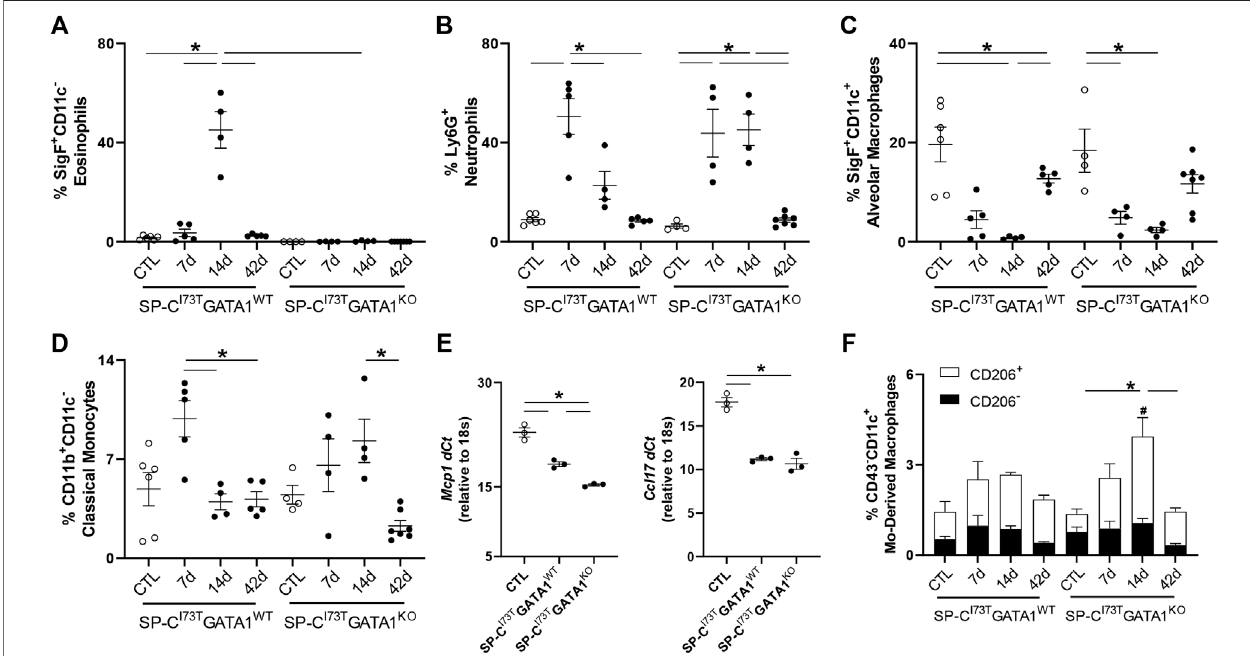
FIGURE 4 | Effects of genetic eosinophil lineage ablation on myeloid in fl ammatory cell dynamics following SP-C I73T induced injury. (A – D,F) Flow cytometric quanti fi cation of (A) Ly6G + neutrophils, (B) SigF + CD11c − CD11b + eosinophils, (C) SigF + CD11c + CD11b − alveolar macrophages, (D) CD11b + CD11c − classical monocytes, and (F) CD43 − CD11c + monocyte-derived macrophages prepared from collagenase digested lungs from oil treated controls (Ctl), or tamoxifen treated SP- C I73T GATA1 WT and SP-C I73T GATA1 KO mice at 7 days,14 days,or42 days postinjury. A p < 0.05 (*)wasconsidered signi fi cant.Lines marksigni fi cantgroups. (E) mRNA analysis of BAL cells isolated from oil treated controls (Ctl), or tamoxifen treated SP-C I73T GATA1 WT and SP-C I73T GATA1 KO mice 14 days post injury. Data is expressed as Delta-Ct relative to 18s housekeeping gene. A p < 0.05 (*) was considered signi fi cant. Lines mark signi fi cant groups. (F) Relative abundance of total CD43 − CD11c + monocyte-derivedmacrophages(MoDMs)inSP-C I73T GATA1 WT andSP-C I73T GATA1 KO mice.Dataarepresentedasmean±SEM( n =5 – 8mice/group), analyzed using two-way ANOVA. A p < 0.05 was considered signi fi cant. Note that each column comprises CD206 − (black); and CD206 + (white) subsets. *Identi fi es signi fi cantdifferencesinthetotalpopulationcomparedtoaircontrols.#Identi fi essigni fi cantdifferenceswithinCD206subsetsversuscontrolgroups.Dataarepresented as mean ± SEM ( n = 5 – 8 mice/group), analyzed using two-way ANOVA.